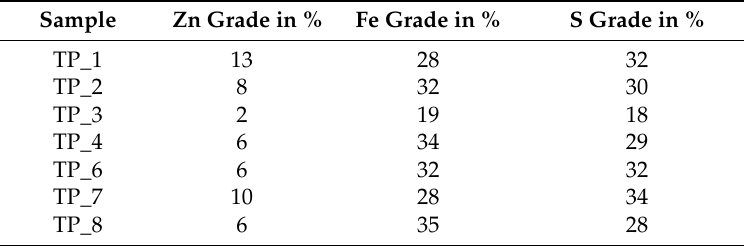
Table 9. Cumulative zinc, iron and sulphur grades of the three concentrates per experiment.